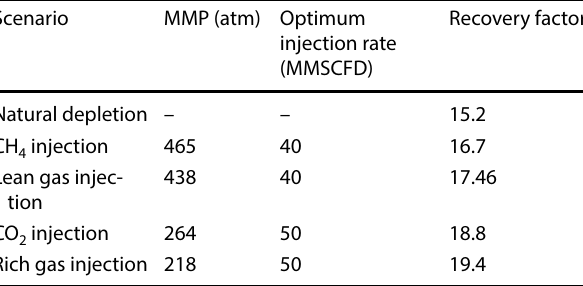
Table 2 Comparison of the different gas injection performance